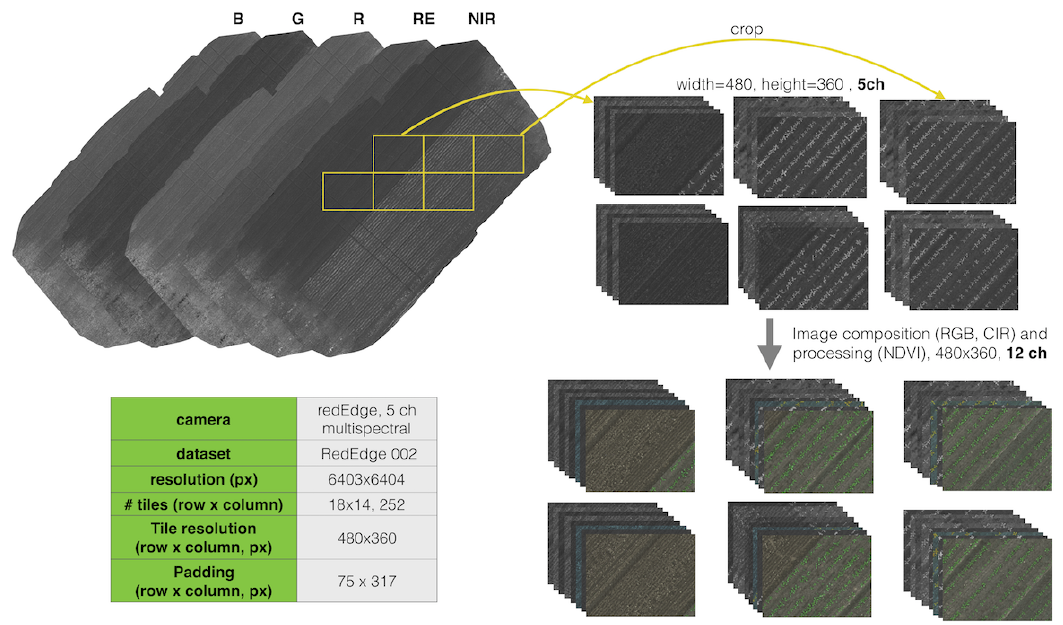
Figure 6. An illustration of tiling from aligned orthomosaic maps. Multispectral images of fixed size ( top right ) are cropped from aligned orthomosaic maps ( top left ). Image composition and preprocessing are then performed for generating RGB, CIR, and NDVI respectively. This yields 12 composited tile channels that are input into a Deep Neural Network